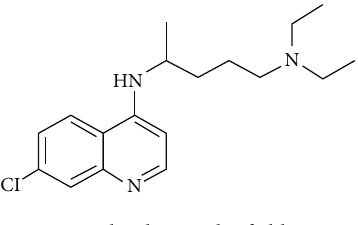
Figure 4: Molecular graph of chloroquine. Table 2: Edge partitioning based on degree of chloroquine.